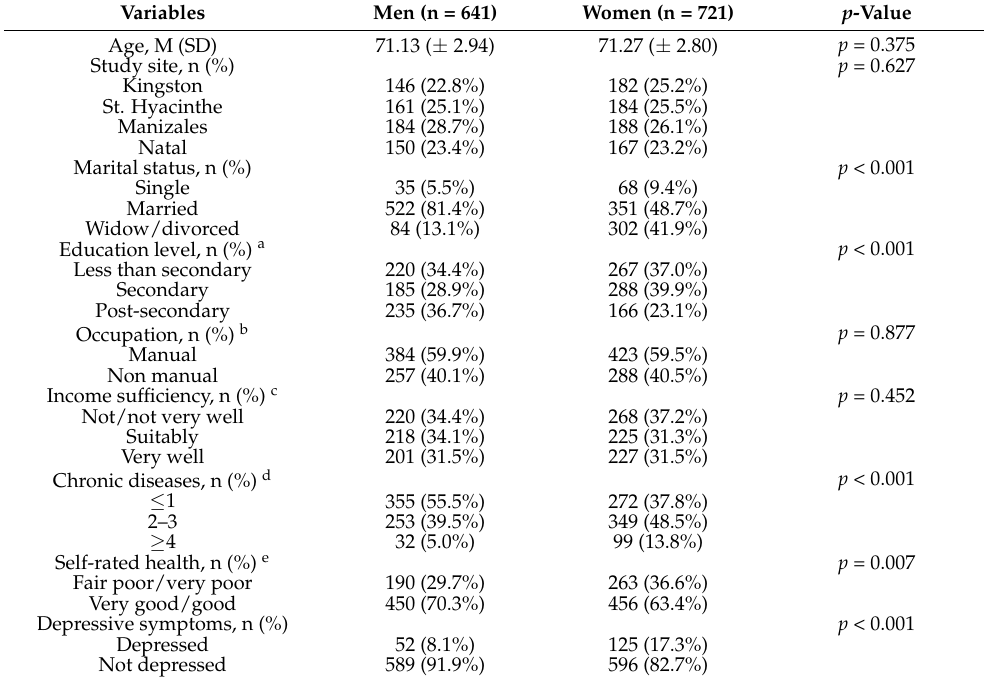
Table 1. Distribution of study survey participants according to socioeconomic and health characteris- tics (n = 1362).